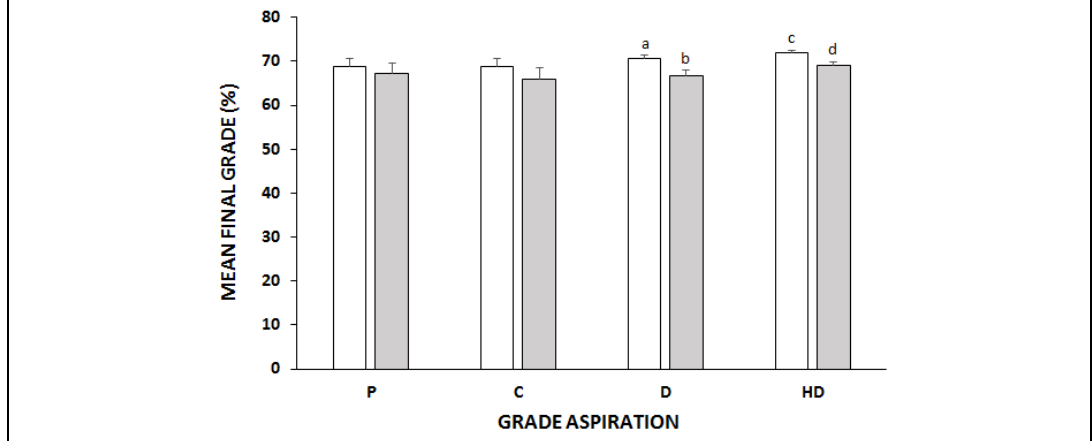
Figure 3: Mean student final grades based on grade aspiration and grouped according to prior biology study (n=550 and 251, respectively). All other indications are as per Figure 2.